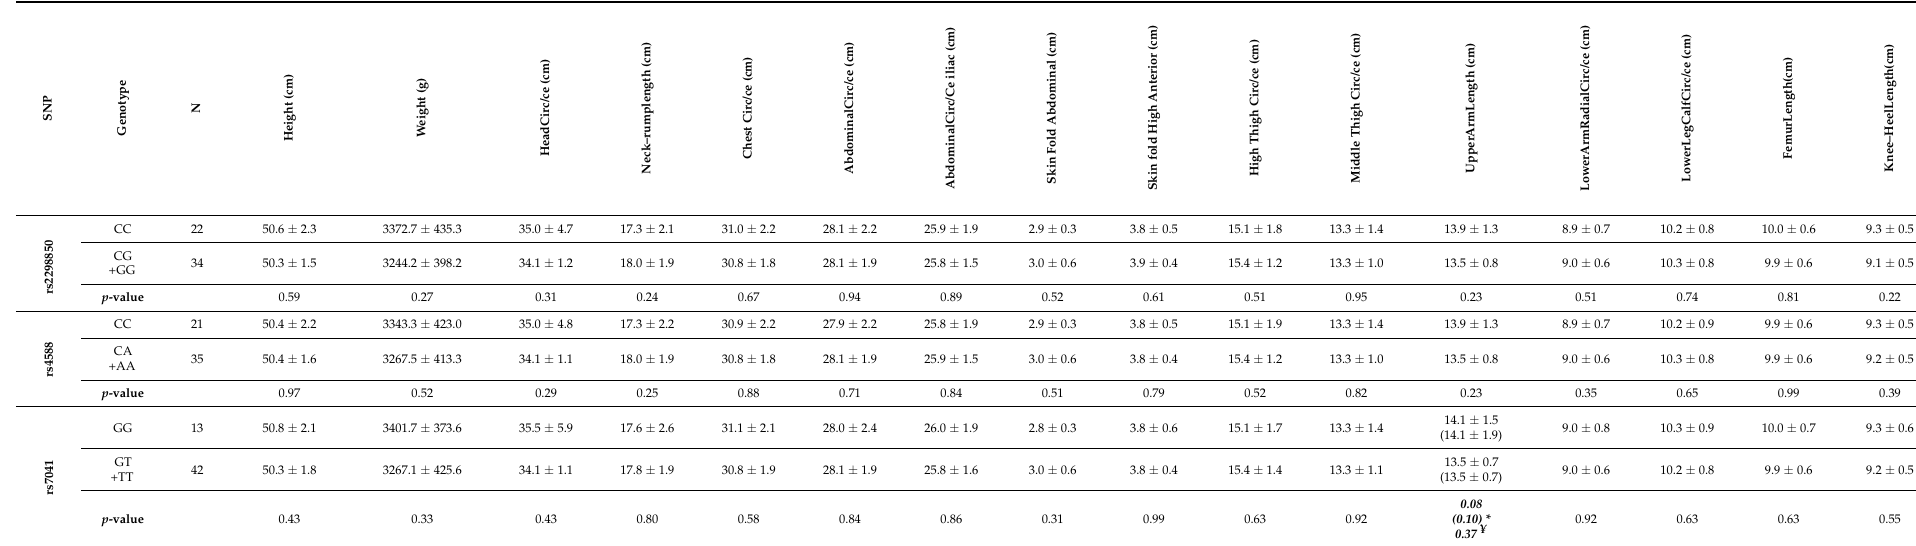
Table 4. Birth neonatal anthropometry (maternal 25(OH)D ≤ 75 nmol/L) according to maternal VDBP polymorphisms. If Levene’s Test for Equality of Variances p > 0.05 then Equal variances assumed Sig (2-tailed) p -values of T-Tests were given. If Levene’s Test for Equality of Variances p < 0.05 then Equal variances not assumed Sig (2-tailed) p -values of T-Tests were given. * The data and p -values adjusted for maternal height (cm), BMI pre-pregnancy (kg/m 2 ), BMI terminal (kg/m 2 ), UVB exposure, and weeks of gestation by One-way analysis of covariance (ANCOVA). Numbers in italics are after adjustments. ¥ Observed power